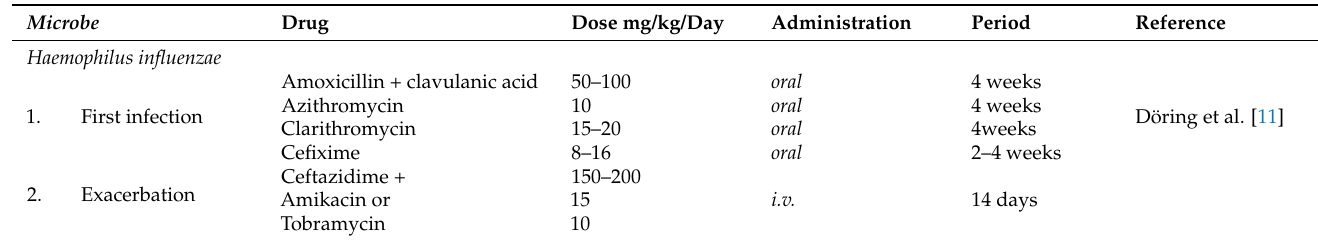
Table 7. Recommended antibiotics for Haemophilus influenzae infection in CF